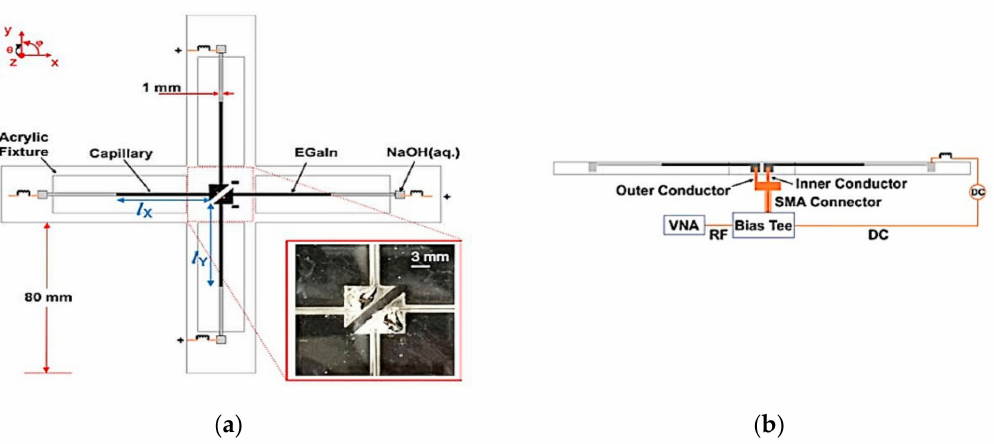
Figure 28. Schematic of the ( a ) reconfigurable crossed dipole, and ( b ) feed detail